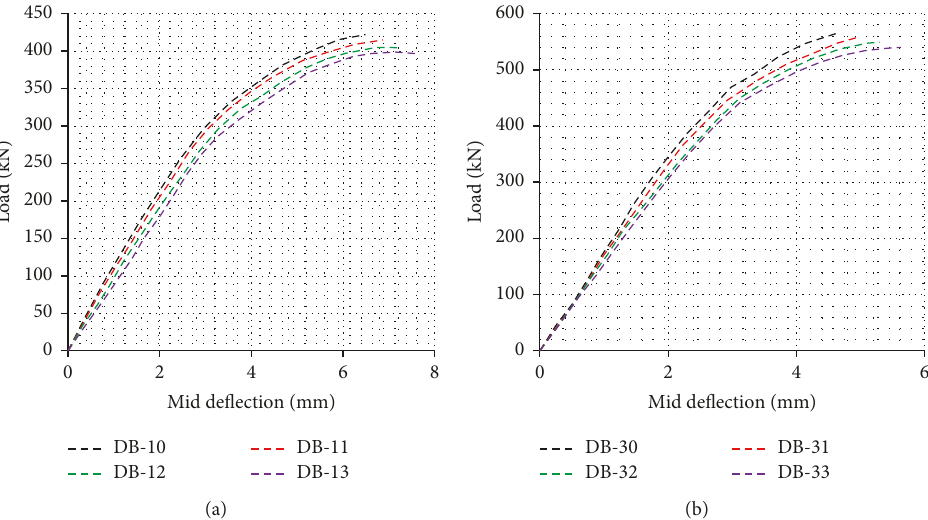
Figure 9: Load-deflection response curves with different L/R ratios of 0, 1.05, 1.31, and 1.57. (a) Beam with L/D ratio equal to 3, and (b) beam with L/D ratio equal to